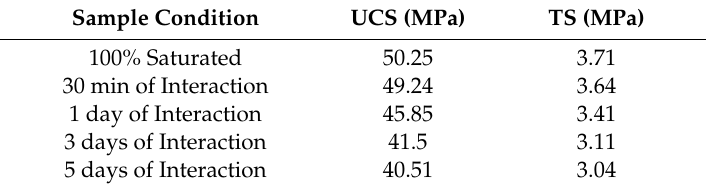
Table 7. Summary of the strength alteration with the extended time of mud interaction.